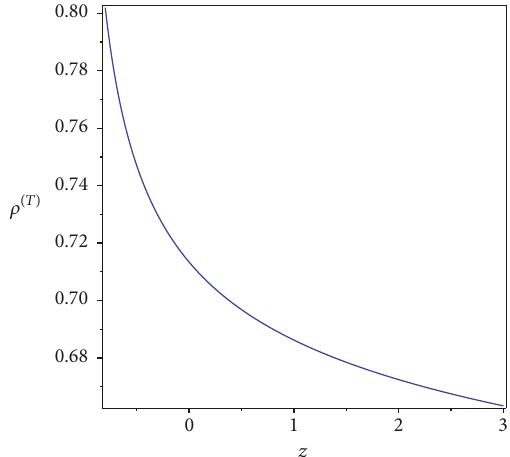
Figure3:Variationoftheeffectiveenergydensityversustheredshift for 𝑓(𝑇) = 𝑇 + 𝜉𝑇(1 − 𝑒 𝛼𝑇 0 /𝑇 ) .